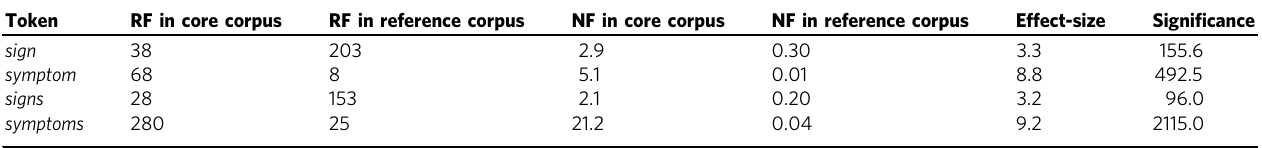
Table 6 Raw (RF) and normalised frequencies (NF) of SIGN/SIGNS and SYMPTOM/SYMPTOMS in English core corpus and English reference